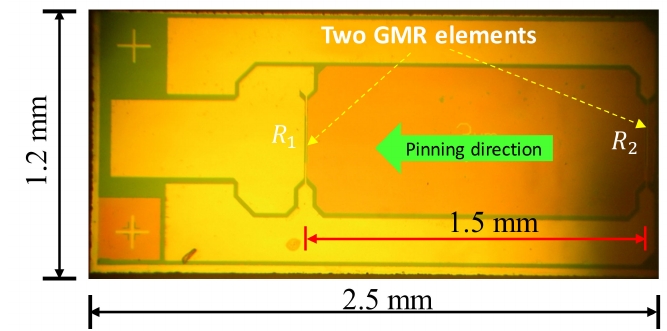
Figure 1. Top view and half-bridge layout of the fabricated GMR